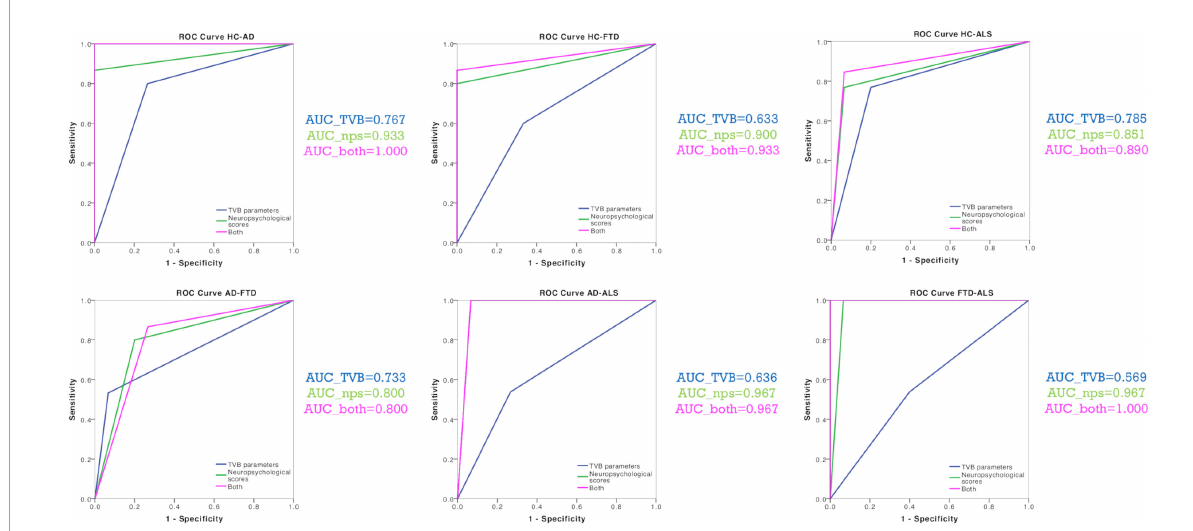
FIGURE4 Classification analysis. ROC curves were calculated for each classification (Healthy Controls vs. Alzheimer’s Disease, Healthy Controls vs. Frontotemporal Dementia, Healthy Controls vs. Amyotrophic Lateral Sclerosis, Alzheimer’s Disease vs. Frontotemporal Dementia, Alzheimer’s Disease vs. Amyotrophic Lateral Sclerosis, Frontotemporal Dementia vs. Amyotrophic Lateral Sclerosis) with their corresponding groups of variables (TVB parameters alone, neuropsychological scores alone, TVB parameters combined with neuropsychological scores). AUC values confirmed that TVB parameters alone (blue) always yielded a poorer discriminant power than that offered by neuropsychological scores alone (green). The combination of TVB parameters with neuropsychological scores improved the discriminative power in all classifications reaching 100% when distinguishing between Alzheimer’s Disease and Healthy Controls and between Frontotemporal Dementia and Amyotrophic Lateral